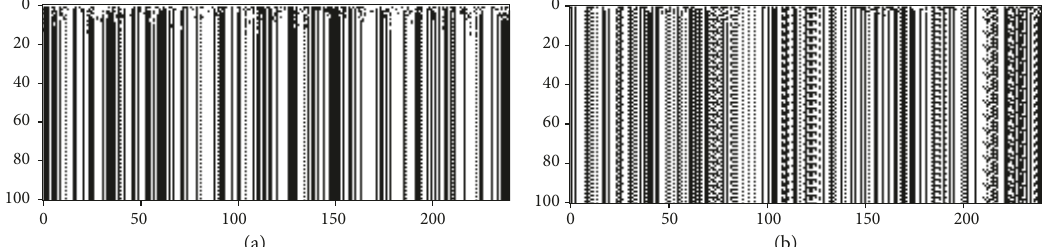
Figure 8: State transitions of networks with N = 240 and K = 2 depending on the number of modules. The states were calculated during 100 timesteps. Time moves downward, columns represent nodes, and colors show states (white represents 0 and black represents 1). (a) Network with 2 modules. (b) Network with 240